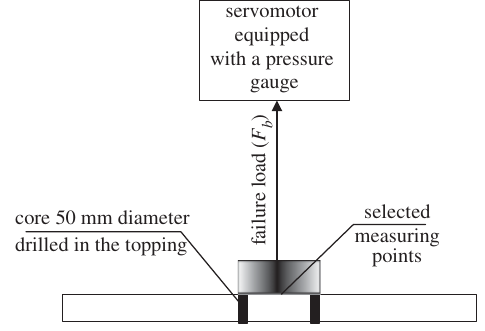
Fig. 6. Schematic of the semi-destructive pull-off method